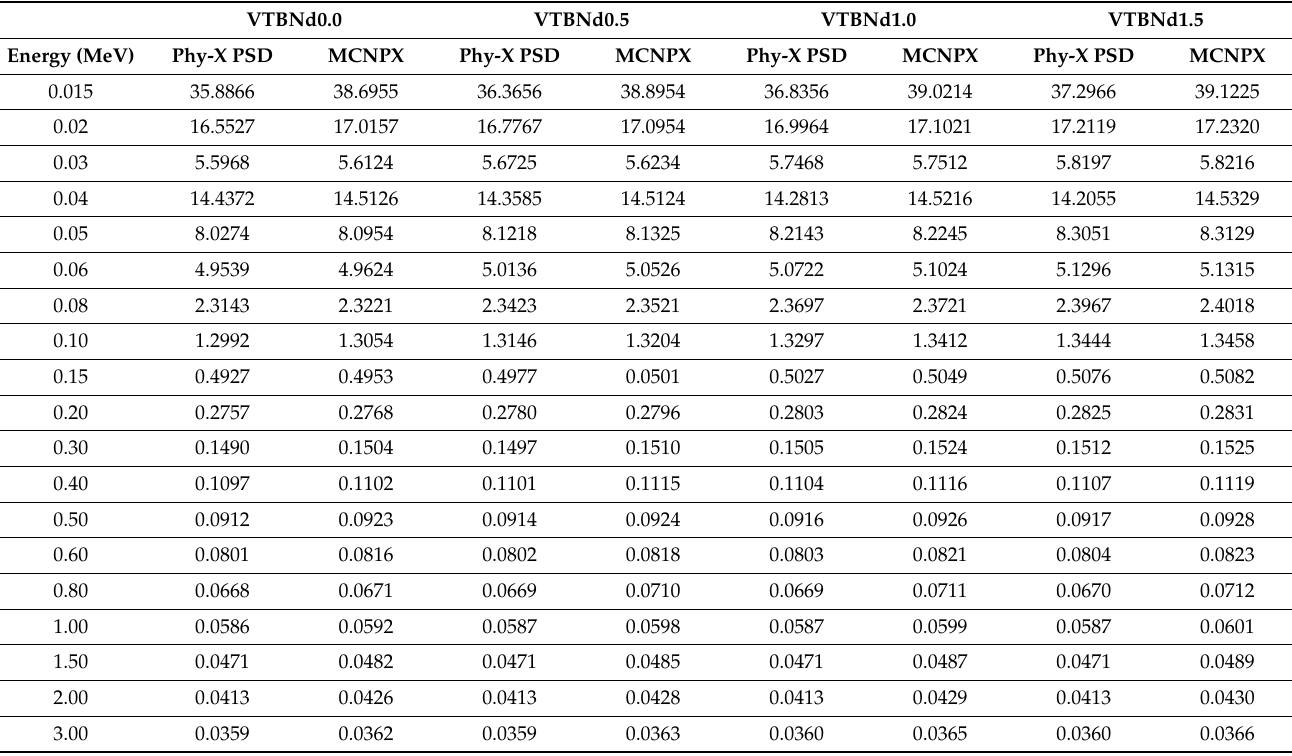
Table 2. Mass attenuation coefficients (MAC) of studied glass samples obtained from MCNPX code and Phy-X PSD program.